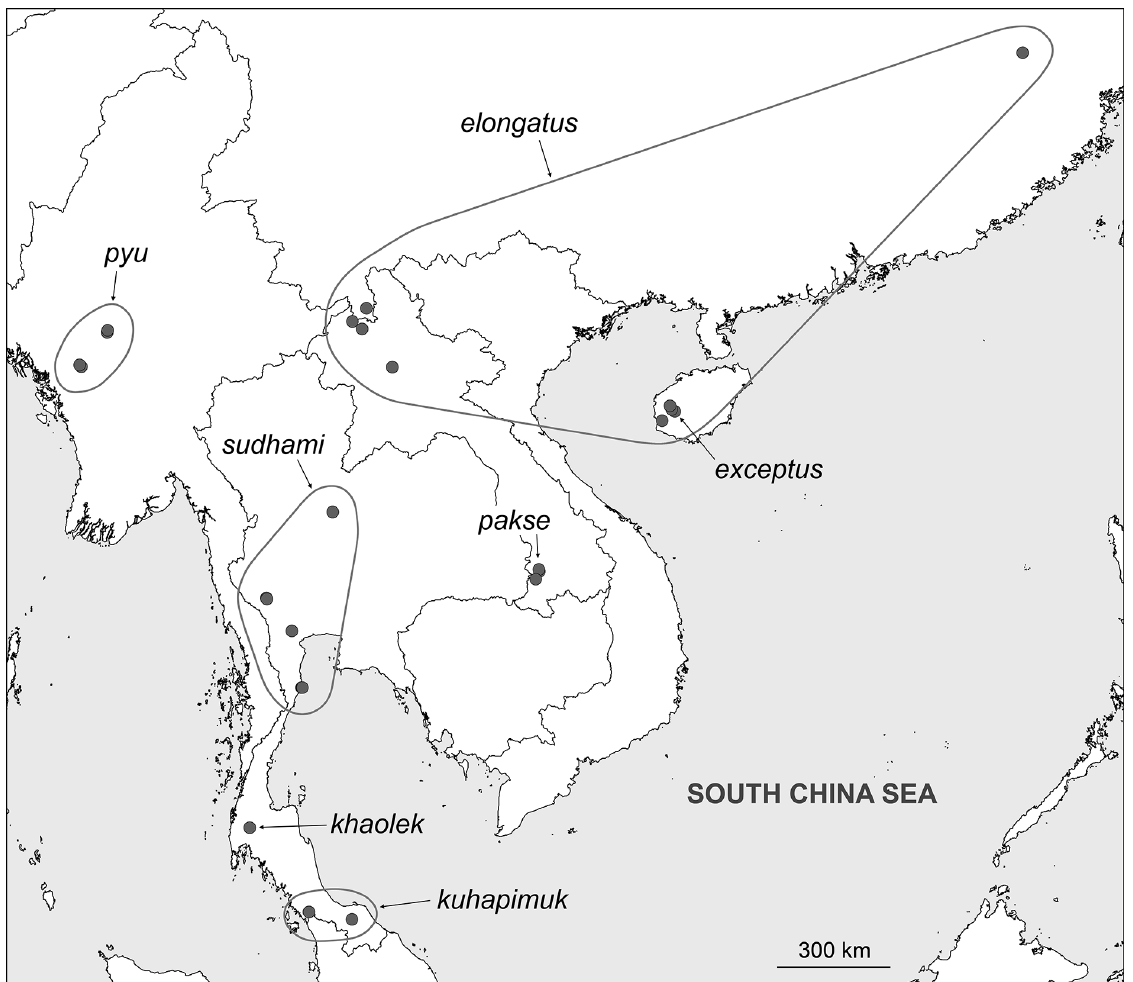
Fig. 57. Known distributions of species tentatively assigned to the Pholcus halabala species